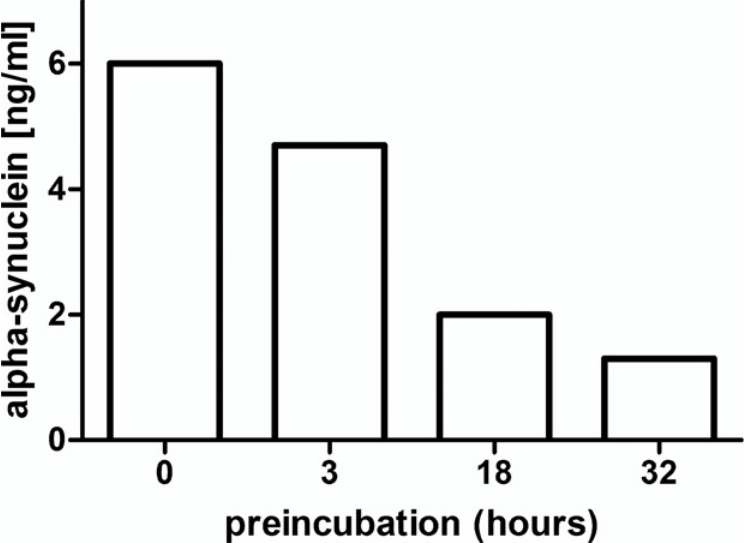
Fig 2. Concentration of an alpha-synuclein standard solution decreases with preincubation. Incubation of freshly diluted alpha-synuclein at 6 ng/ml in PBS for 3, 18 and 32 h at 37°C decreased ELISA- measured alpha-synuclein levels by 21, 66 and 78%, respectively.